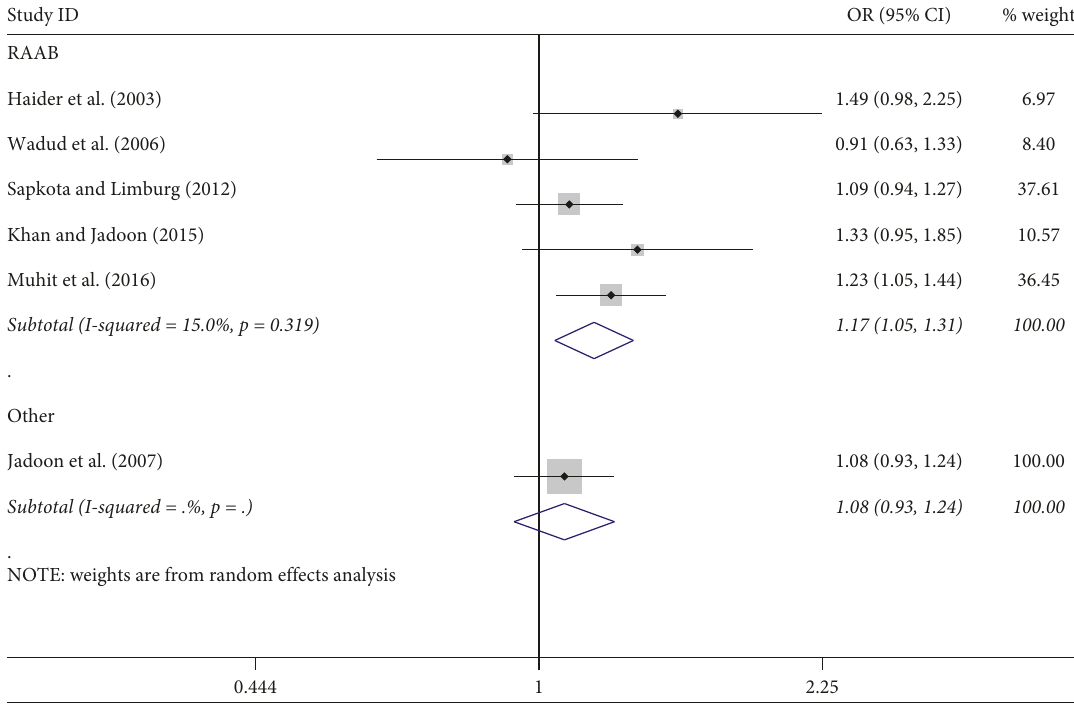
Figure 7: Subgroup analysis of CSC by design on a person basis at visual < 6/18 level. CSC � cataract surgical coverage; OR � odds ratio; CI � confidence interval.